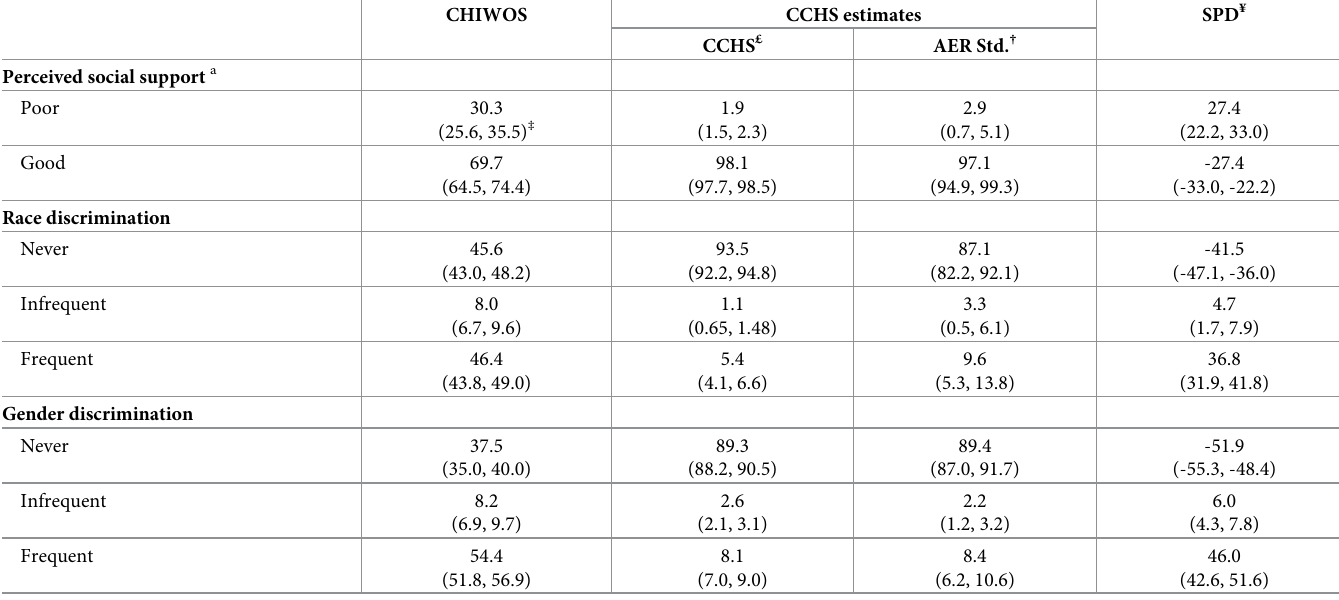
Table 3. Comparing social support � , and racial and gender discrimination �� between women living with HIV (CHIWOS; 2013–2015) and the general population of women in Canada (CCHS; 2013–2014).